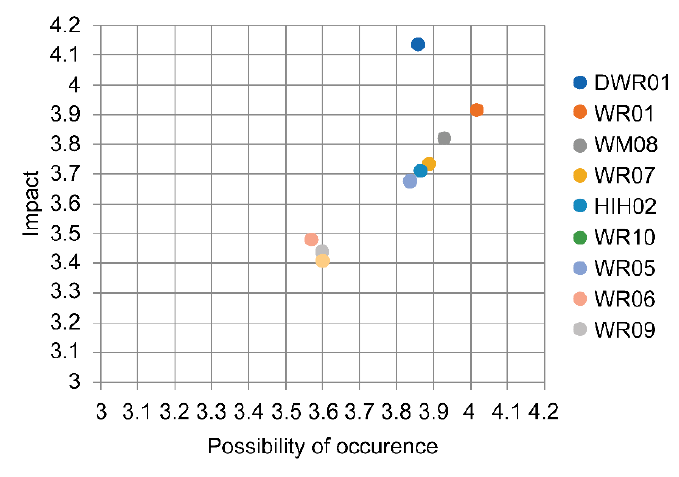
Figure 2. Top 10 risk factors.